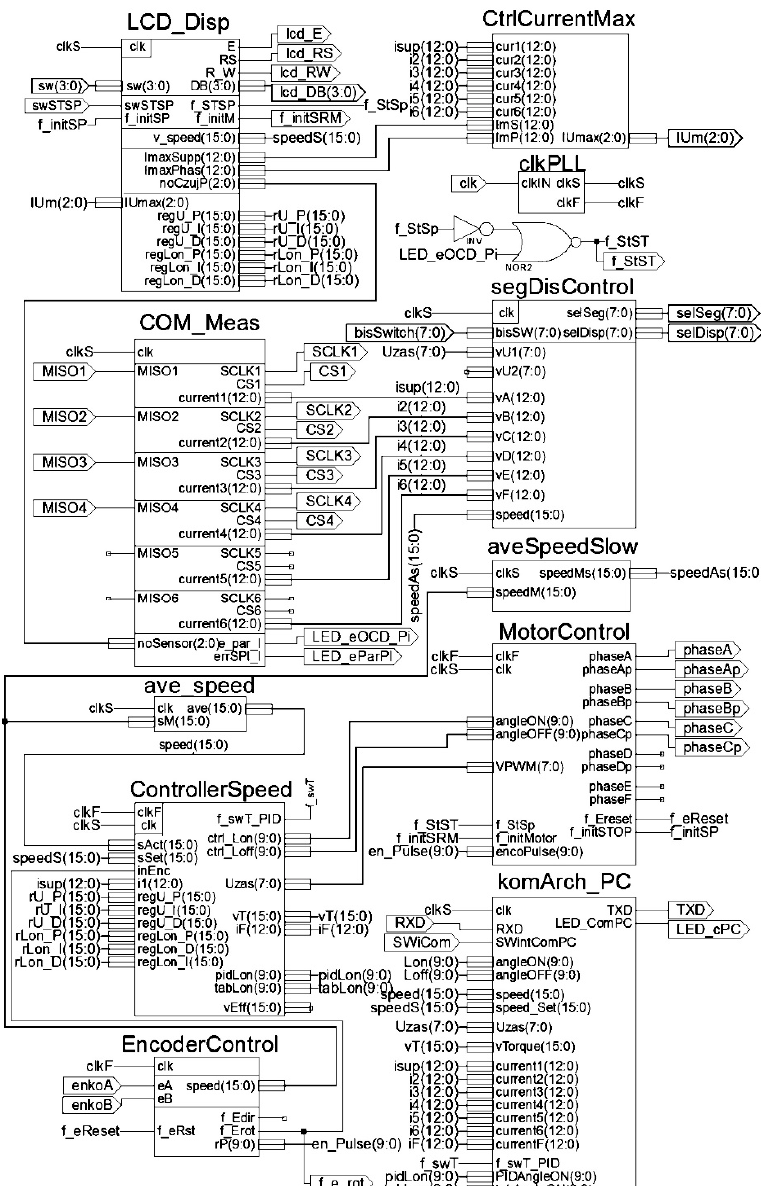
Figure 10. Schematic diagram of the control system implemented in the FPGA device.